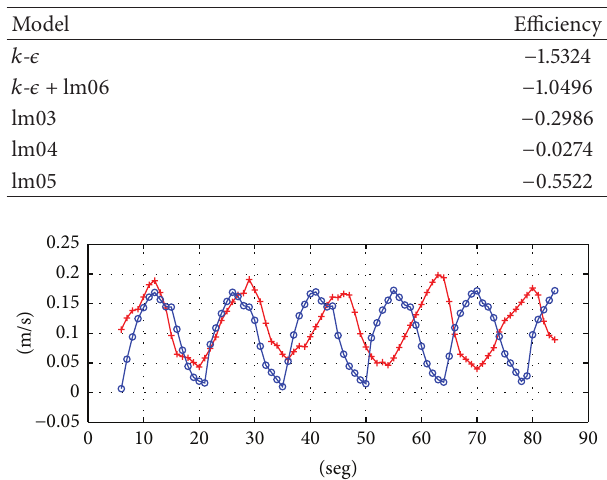
Table 1: Efficiency results for each turbulence model. Model